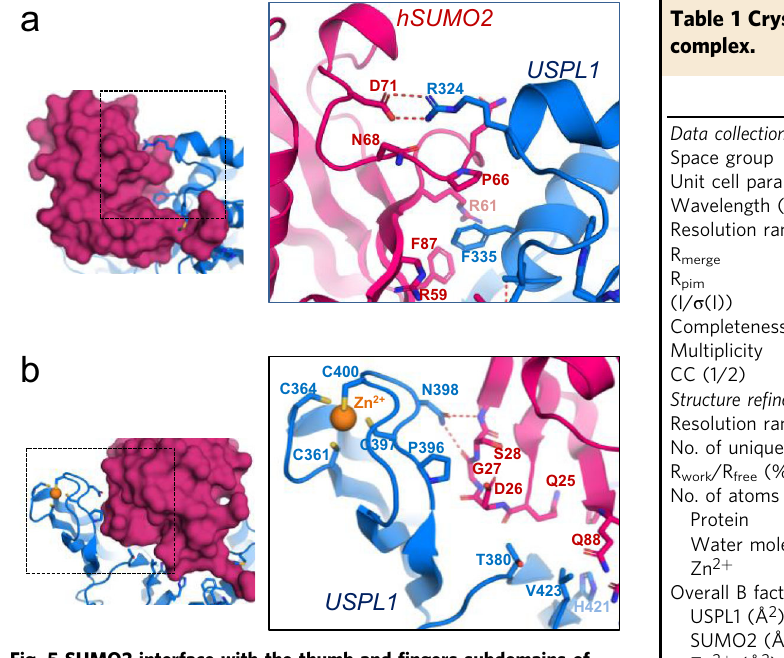
Fig. 5 SUMO2 interface with the thumb and fi ngers subdomains of USPL1. a Stick representation of the main contacts of the thumb subdomain of USPL1 with SUMO2. USPL1 catalytic domain and SUMO2 are shown in blue and red, respectively. SUMO2 and USPL1 interface residues are labeled. Dashed lines indicate hydrogen bond contacts. On the left side, surface representation of SUMO2 (red) in complex with USPL1, shown in a blue cartoon. Interface residues are shown in stick representation. Zinc atom is shown in yellow. b Stick representation of the main contacts of the fi ngers subdomain of USPL1 with SUMO2. Same color code as in ( a ).